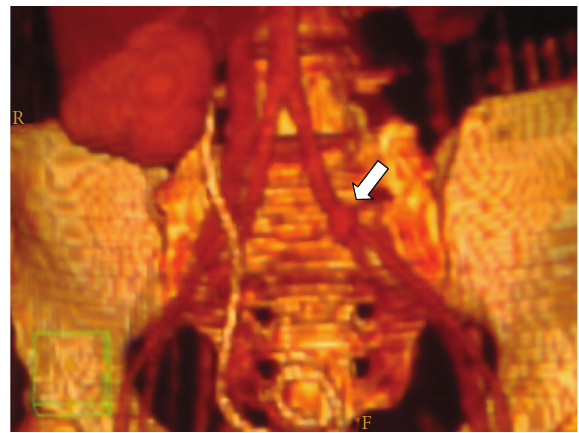
Figure 2: 3D CT rendering showing pseudoaneurysm of left common iliac artery where it cross the left ureter (white arrow). The latter is not visible because of not functioning left kidney.